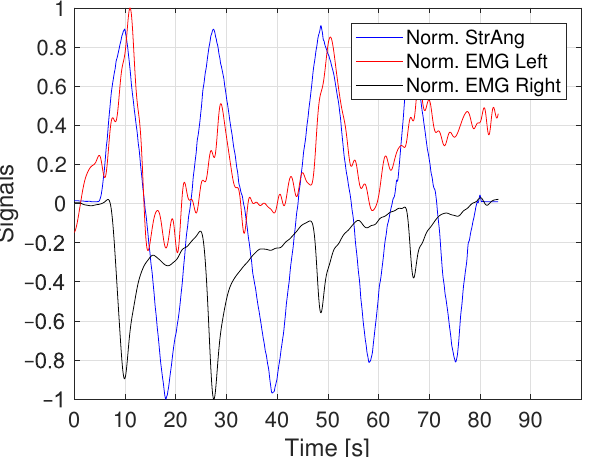
Figure 13. Normalized EMG activity Flexor Carpi Radialis (FC) (i.e., lower arm) over time.